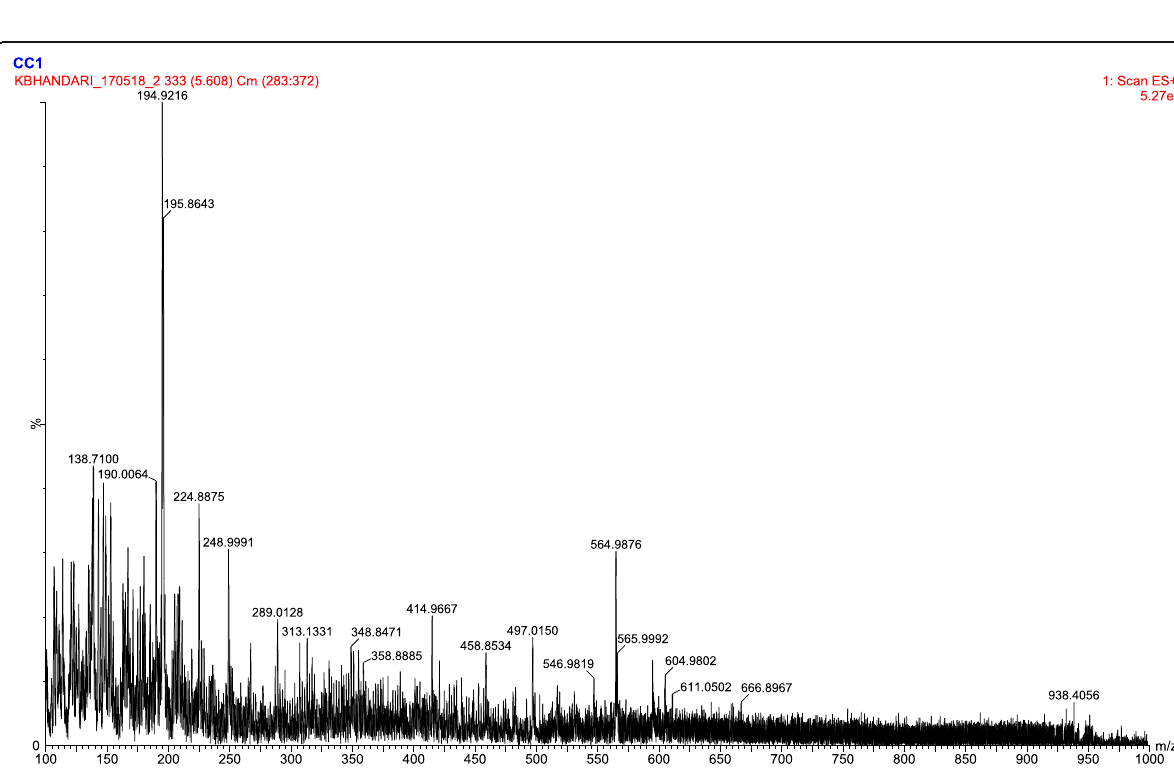
Fig. 5 Representive MS spectra in positive mode of compounds in VABT eluted at 5.6 min retention